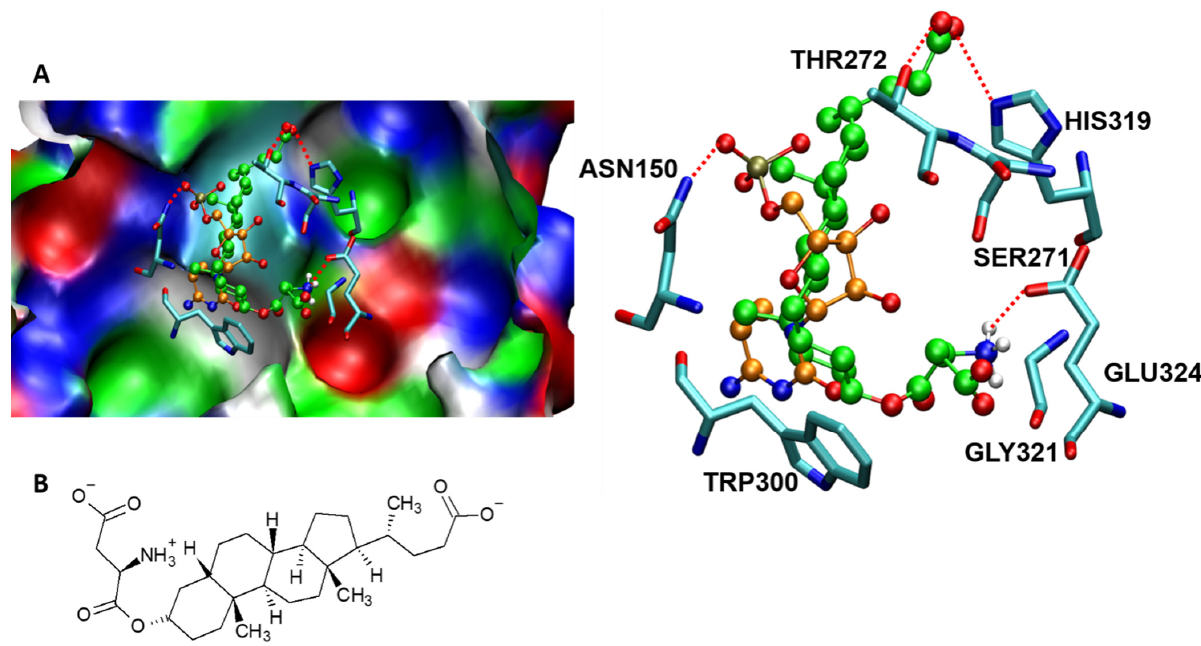
Figure 11. ( A ) The molecular docking of Lith-O-Asp to mammalian sialyltransferase (PDB ID: 2WNB). Lith-O-Asp is shown in green and CMP is shown in orange. Hydrogen bonds are shown with dotted red lines. The highlighted interactions between Lith-O-Asp and amino acids of the binding sites are shown in the right panel. ( B ) Structure of Lith-O-Asp used as an inhibitor for the docking study.